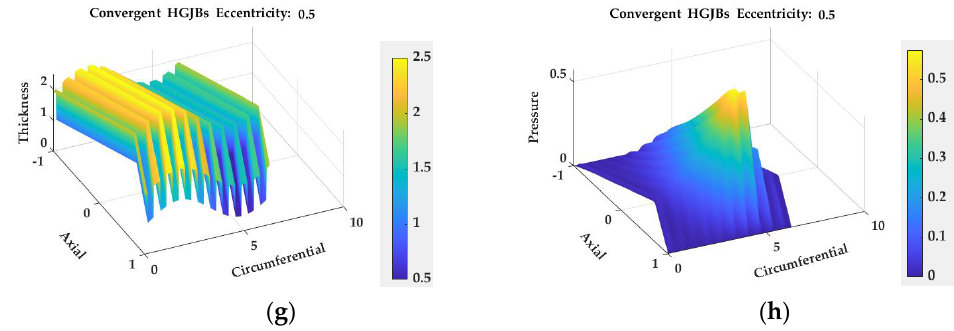
Figure 13. Comparison of two bearing oil film thickness and pressure: ( a , b , e , f ) are the calculation results of the constant—width HGJBs; ( c , d , g , h ) are the calculation results of the convergent HGJBs.